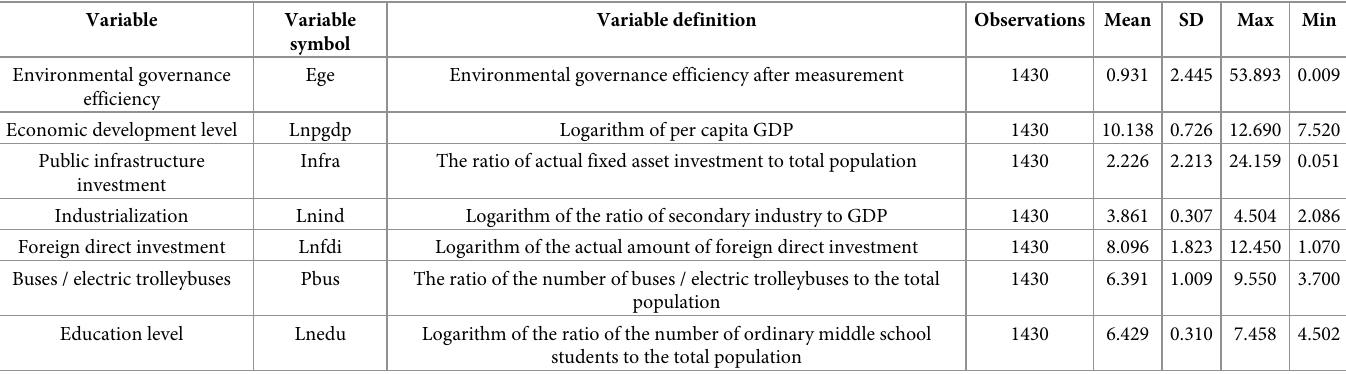
Table 2. Main variables and descriptive